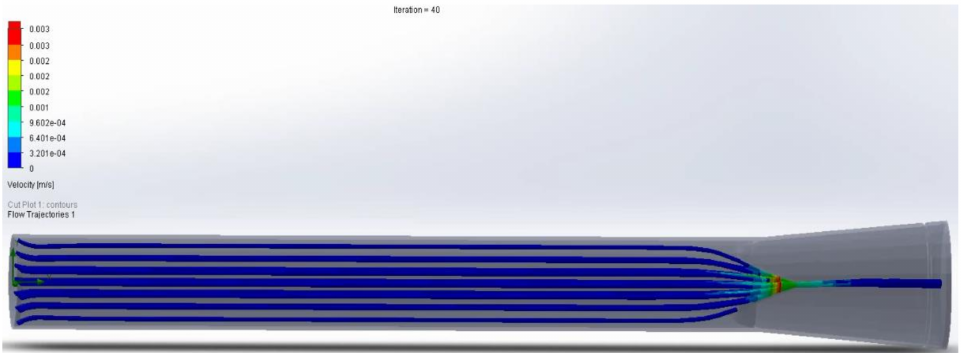
Figure 16. Computer velocity test simulation analysis of fluid with pressure of 32 mmHg to 25 mmHg